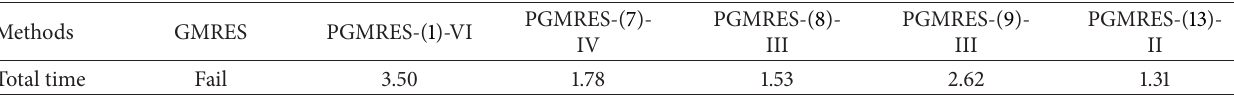
Table 3: Comparison of the computational time in solving the linear system resulting of discretization of (51) when 𝑛 = 1500 . Methods GMRES PGMRES-(1)-VI